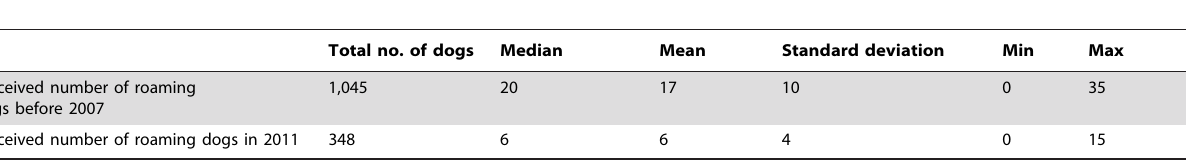
Table 11. Summary table of individuals’ perceived number of roaming dogs in five wards in Colombo City before and after the implementation of the intervention activities reported by 61 focus group